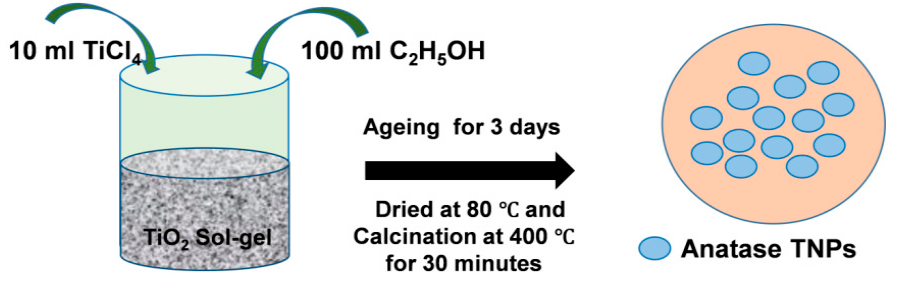
Figure 1. A detailed schematic route of anataseTiO 2 nanoparticle (TNP) preparation by sol-gel method.